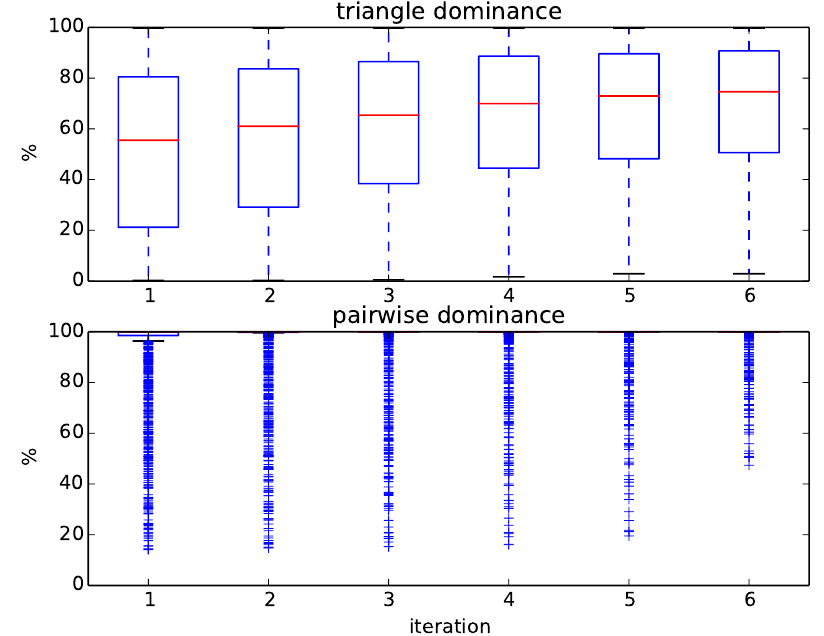
Figure 7. Boxplots of the percentage of removed targets at each iteration during triangle and pairwise dominance for the 1369 queries of the extended SCOPCath